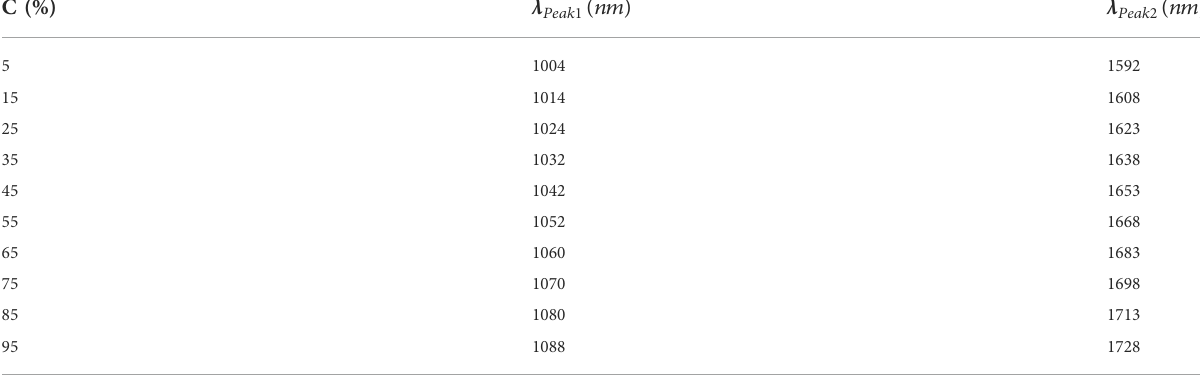
TABLE 7 Resonance wavelengths corresponding to different